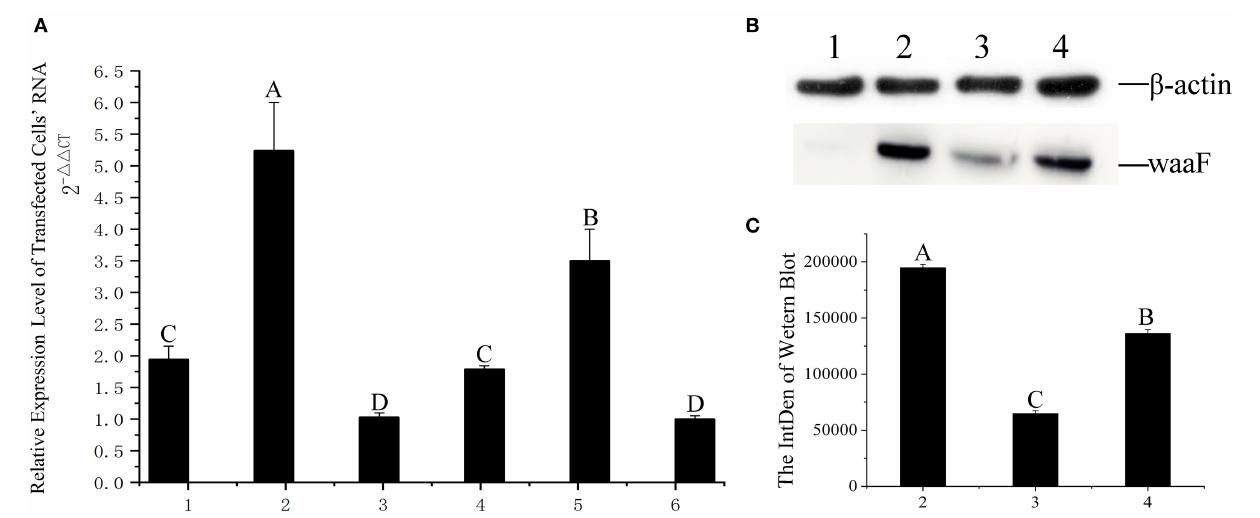
FIGURE 3 | (A) qRT-PCR was applied for assaying the level of expression at RNA level, 1–6: The same positive cells were cultured in six vials, their RNA extracted, and numbered 1–6, respectively; the difference between different capital letters is extremely significant ( p < 0.01). (B) The expression of waaF protein. Lane 1, protein of MCF-7 cells. Lane 2–4, the waaF expression was observed in No. 2, No. 3, and No. 4 cells. (C) The curve of the western blot expression band; the difference between different capital letters is extremely significant ( p < 0.01).